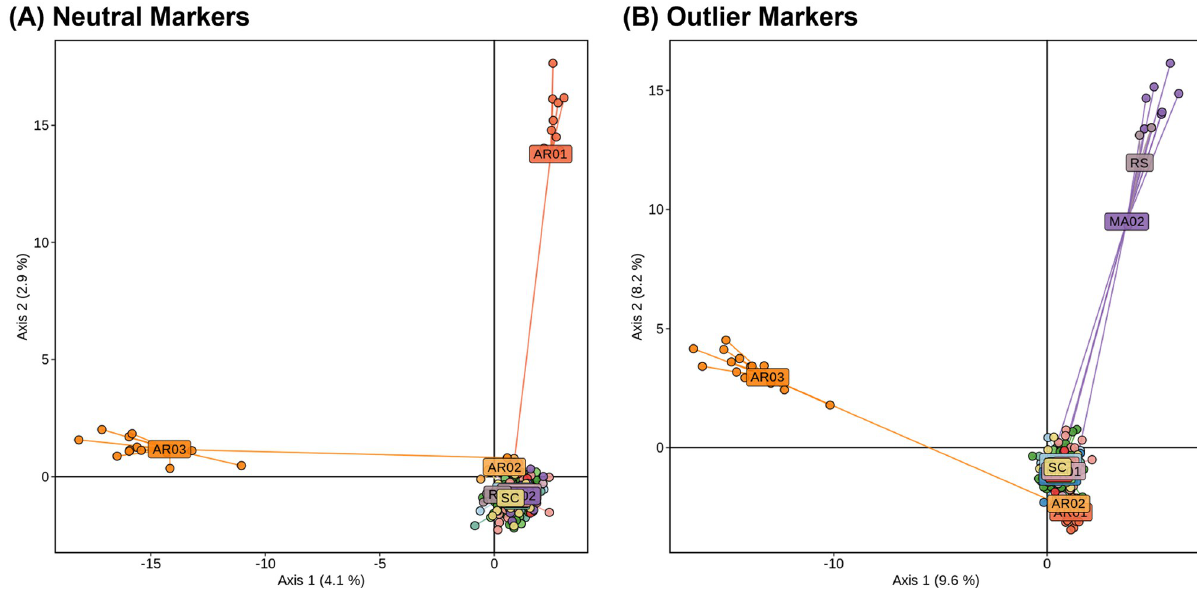
Fig 4. PCA analysis generated with (A) 2,853 neutral SNPs, (B) 456 outliers. Dots represent different individuals of each location.